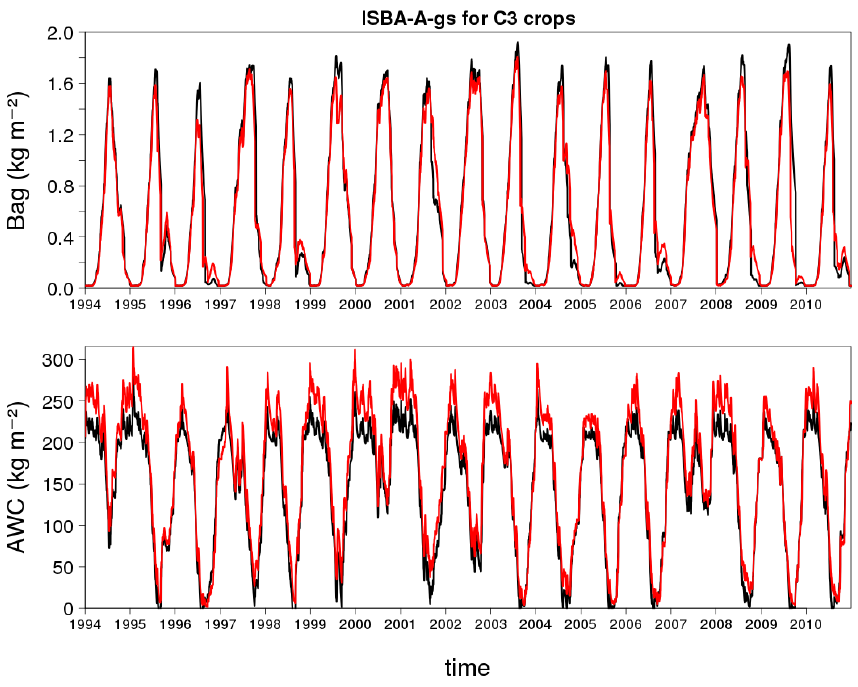
Figure 7. Simulations over the 1994–2010 period for C3 crops ( g m = 1.75mms − 1 , MaxAWC = 200mm) in the 61-Orne département of (top panel) the above-ground biomass and (bottom panel) the available water content in the root zone, using the FR-2L and DIF1 configurations (black and red lines, respectively).